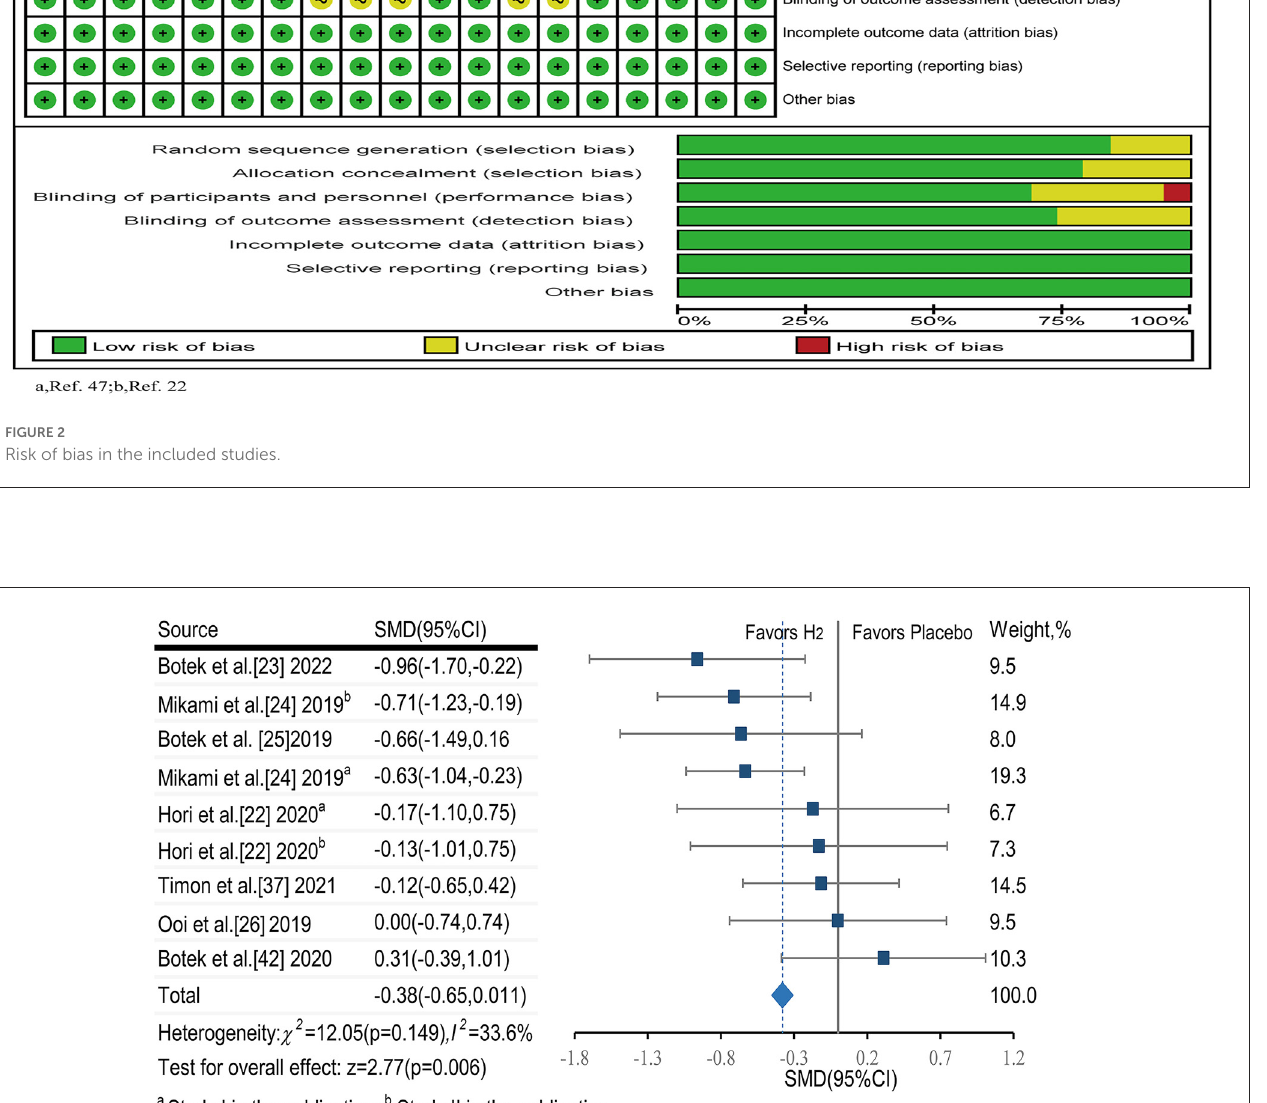
by reducing oxidative stress and neuroinflammation (51–54). H 2 intake has also been reported to induce positive effects on exercise acidosis and reduce blood lactate concentration (26), thus modulating intracellular and extracellular buffering capacity during high-intensity exercise (55). It is also possible that the